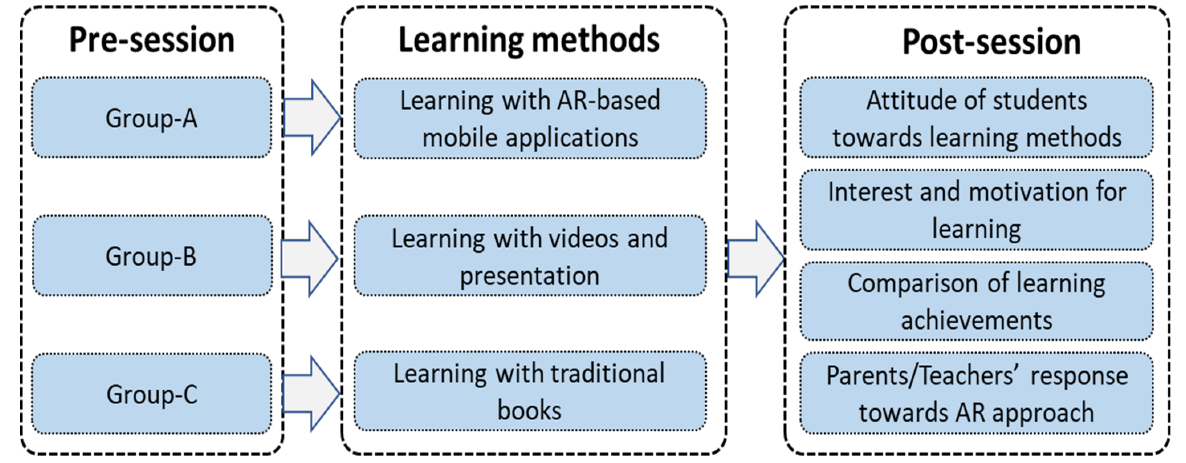
Figure 9. Pre-session arrangement of the groups based on the student’s previous academic records, and activities plan of the experimental study.